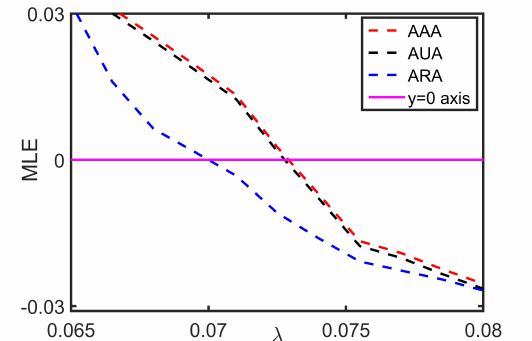
Figure 3. Maximum Lyapunov Exponents (MLEs) as a function of λ supporting the results pres- neted in Figure 1. Red, black, and blue dashed curves display MLEs for AAA, AUA, and ARA configurations, respectively. Purple horizontal line indicates zero-level.